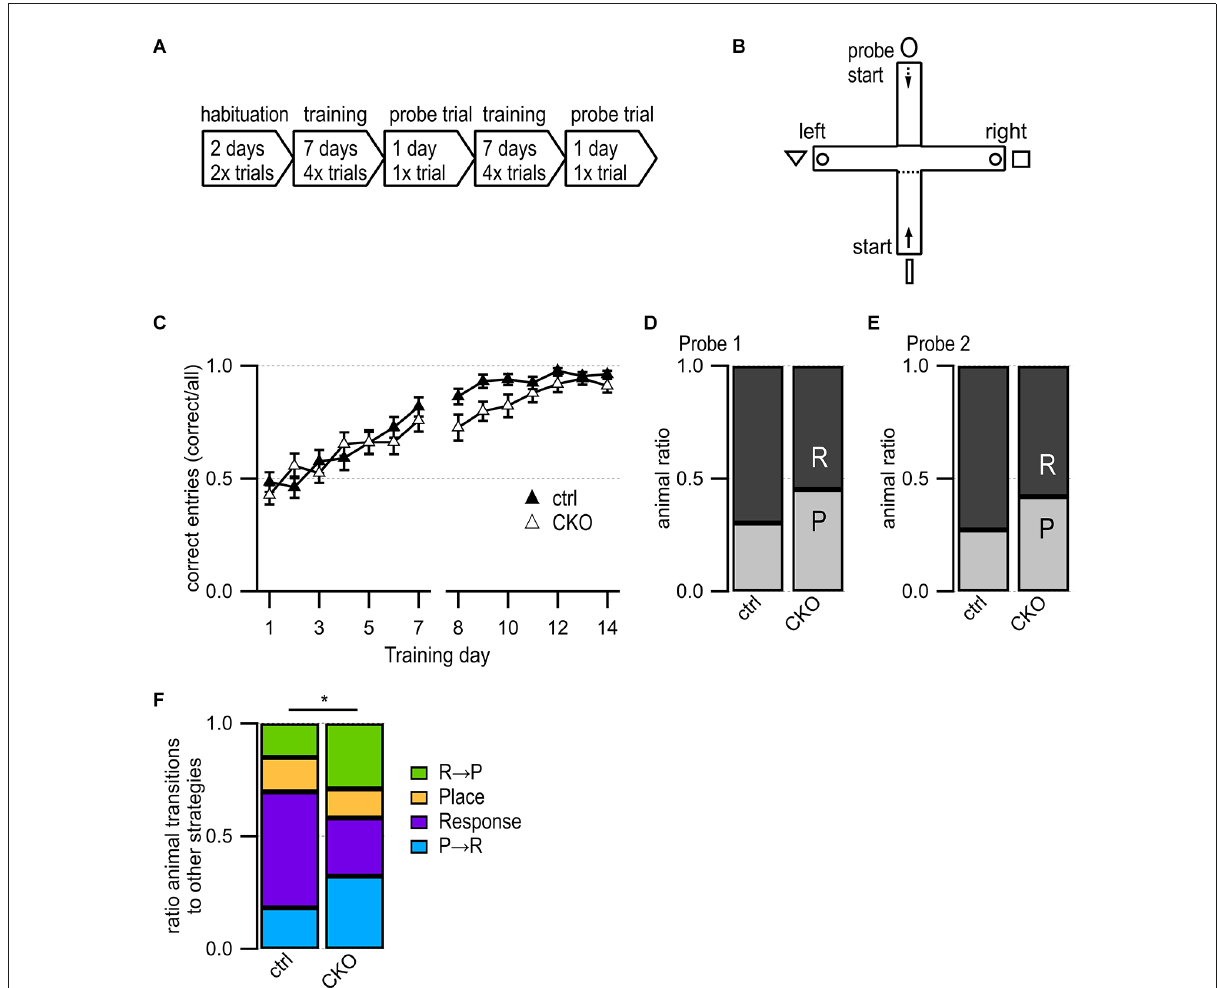
FIGURE3 Loss of GABA co-transmission from ACh neurons leads to changes in usage of competing learning strategies. (A) Timeline of T maze experiment. Habituation phase for 2 days, training phase for 7 days followed by one probe trial day. Repetition of the training phase for another 7 days followed by one probe trial day. (B) T-maze setup. Animals start in the south arm during habituation and training but from the north arm during probe trials. Visible fabric cues attached to the curtained walls outside of the maze. Food bowls (circle) were placed at ends of both goal arms. Start points for training indicated by continuous arrow and for probe trials by dashed arrow. (C) Training success indicated as correct entries into goal arms for every training day. (D,E) Results for Probe trial day 1 (D) and Probe trial day 2 (E) indicating the relative number of response (R) and place (P) learners. (F) Animal ratios were sorted by learning strategy and strategy transitions from probe trial 1 to probe trial 2: place transitioner (R → P, green), consistent place (orange), consistent response (purple), response transitioner (P → R, turquoise). Values represent mean ± SEM. Repeated Measures Proportional Odds Logistic Regression model (C) and Fisher’s exact test (F) (* p < 0.05). See Supplementary Table 4 for